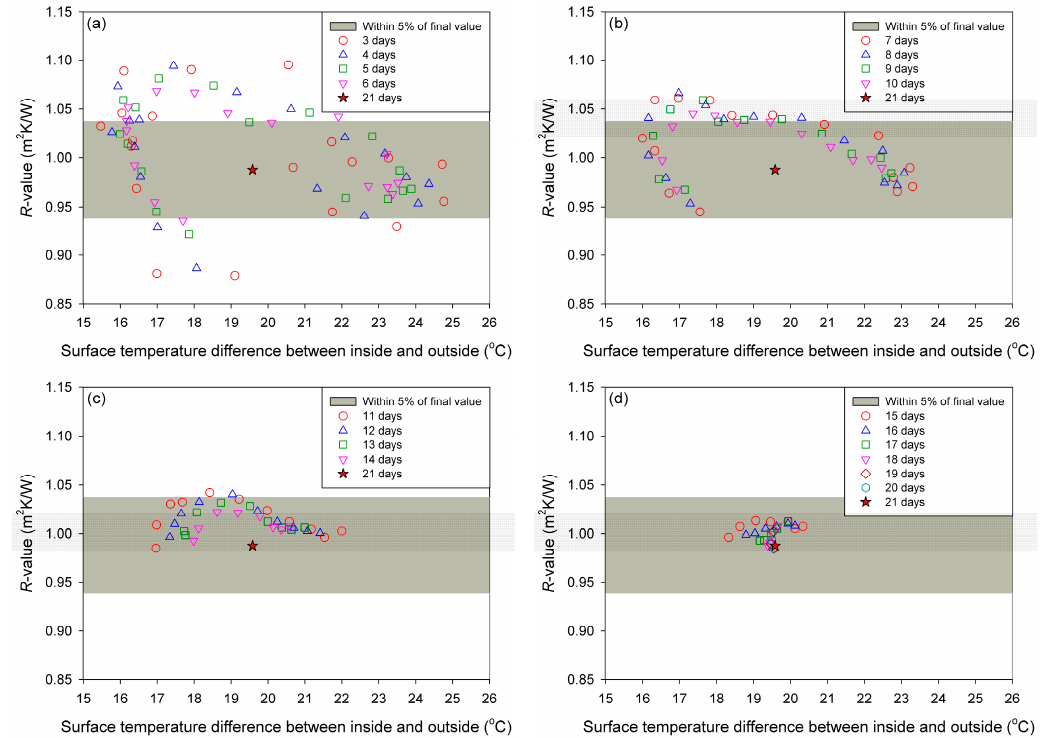
Figure 9. Relationship between average surface temperature differences and final R -values evaluated for different analysis periods. For ease of understanding, the plots are divided into four sub-figures based on the length of the analysis period: ( a ) 3–6 days; ( b ) 7–10 days; ( c ) 11–14 days; ( d ) 15–20 days.